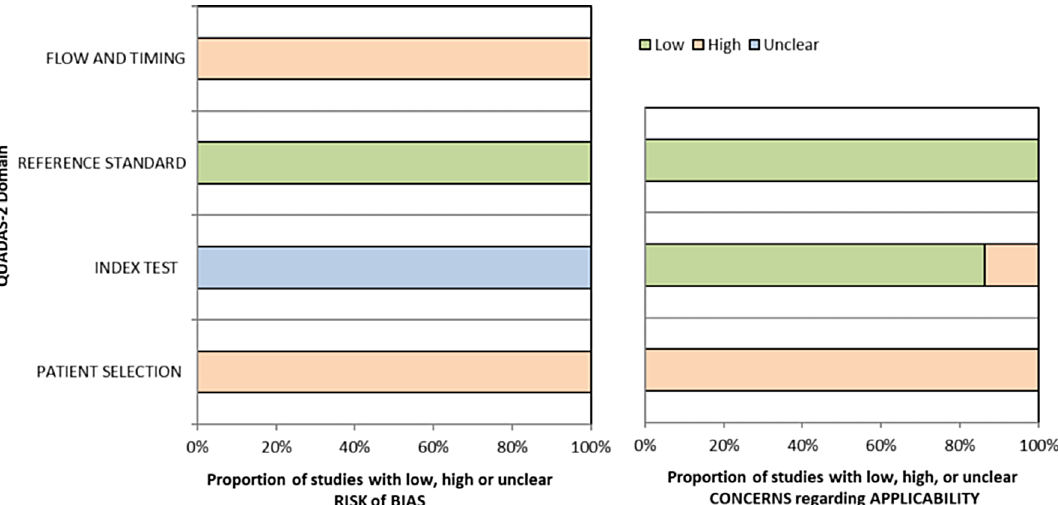
Figure 6. Risk of bias and applicability concerns for the 22 articles included in the review. QUADAS-2 results summarize quality assessment for patient selection, index test, reference standard and fl ow and timing. This fi gure was generated using the QUADAS website. (https://www.